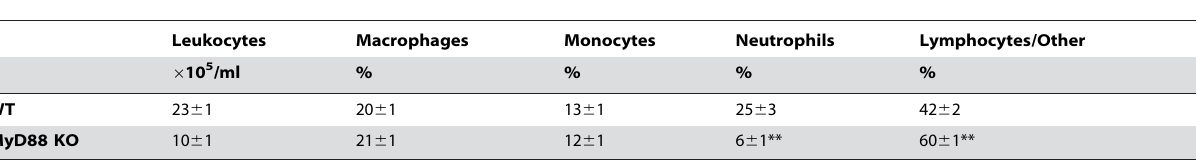
Table 2. Effect of MyD88 deficiency on total and differential lung cell